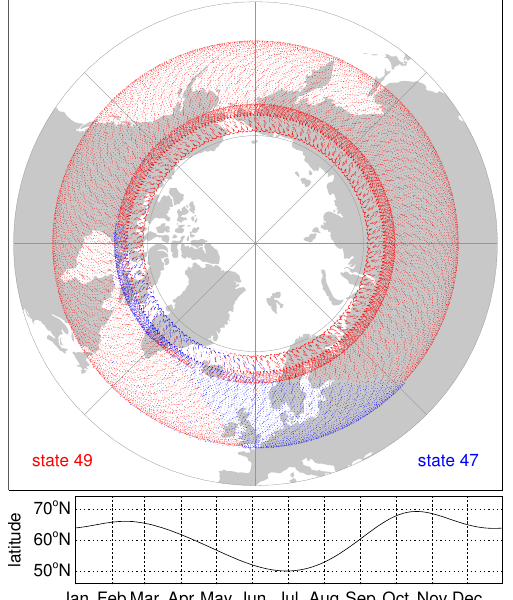
Fig. 1. Geographical distribution of SCIAMACHY solar occultation events. Top panel: all tangent points for the years 2003 to 2010 are plotted. Red dots are the nominal solar occultation measurements (state 49), blue dots are the shortened measurements (state 7). Bot- tom panel: the tangent points latitude over the year.